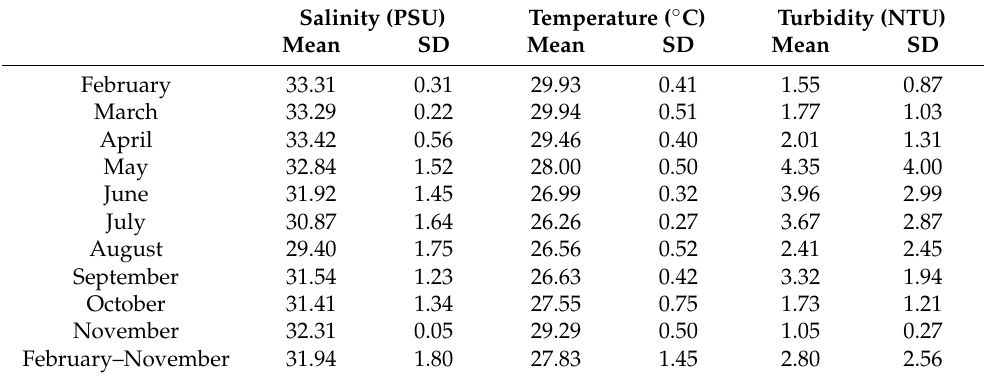
Table A4. Mean ( ± 1 SD) salinity, temperature and turbidity measured at Warrior Reef in 2020 ([22], modified).